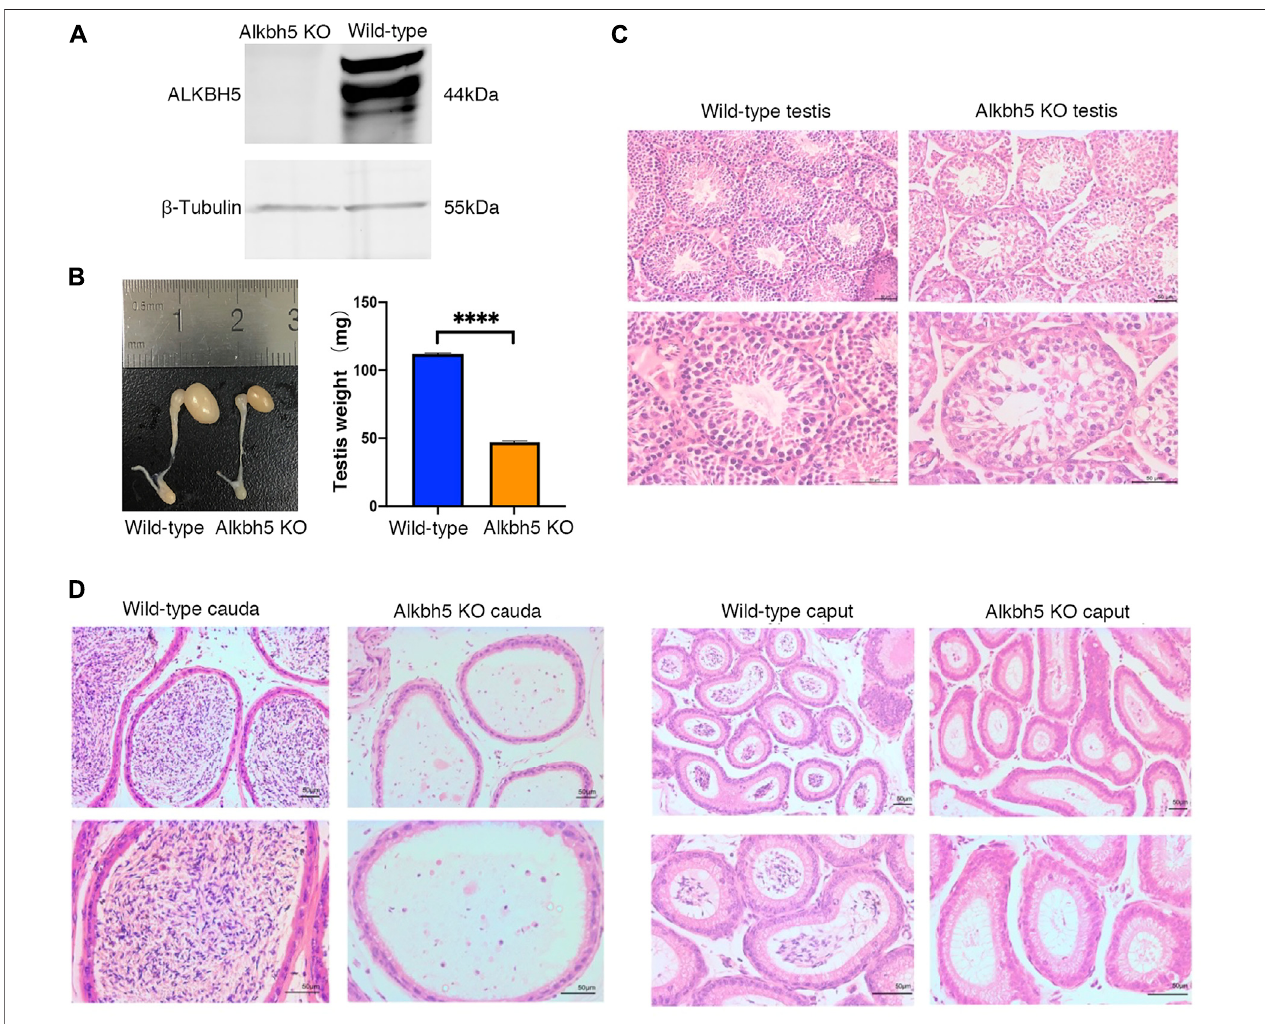
FIGURE 1 | Western blot analysis of the ALKBH5 protein. β -Tubulin was used as the loading control (A) . Representative right testes and right epididymis from 12-week-old WT and Alkbh5 KO mice (left image). Average testis weight from 12-week-old WT and Alkbh5 KO mice (right image) Bars indicate means ± SEM (n = 10, **** p < 0.0001) (B) . Seminiferous tubule architecture ofWT and Alkbh5 KO mice werestained with hematoxylin-eosin (H&E) (Scalebars, 50 μ m) (C) . Cauda and caput epididymis from WT and Alkbh5 KO mice stained with H&E (Scale bars, 50 μ m) (D)